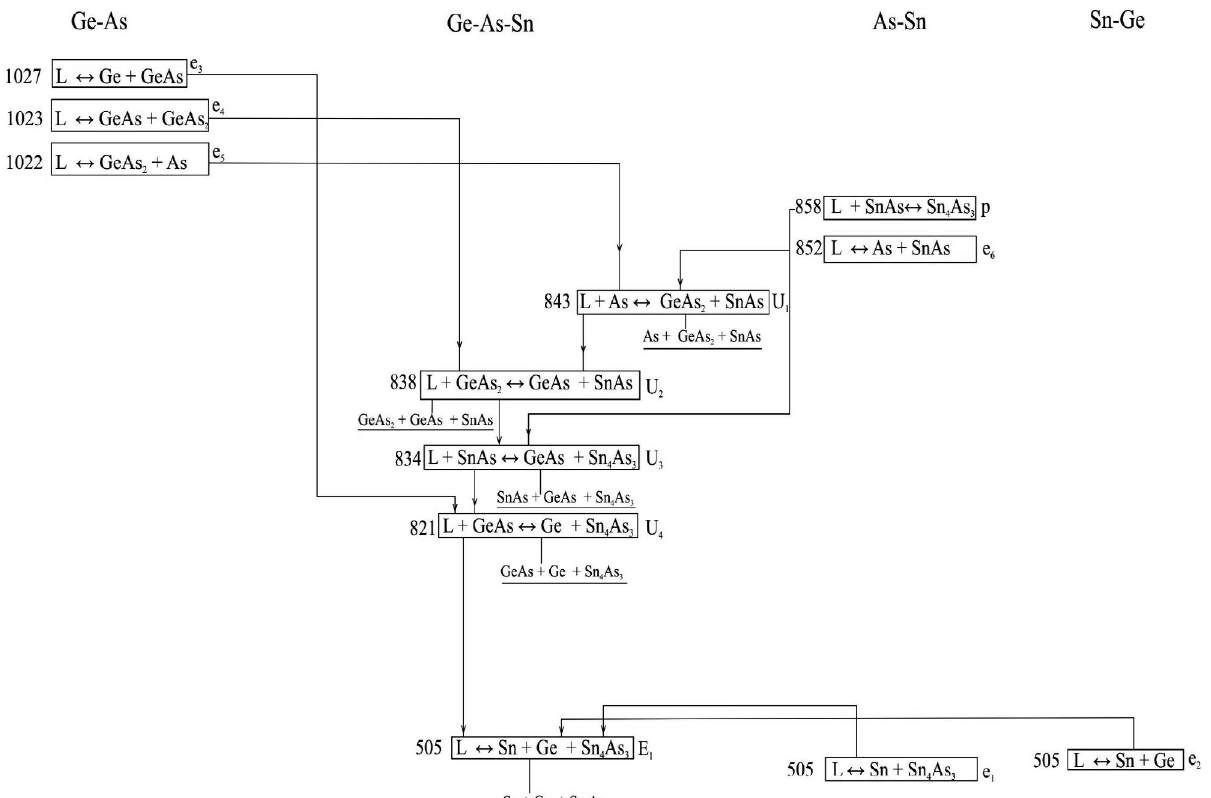
Figure 14. Flow diagram of the Sn–As–Ge